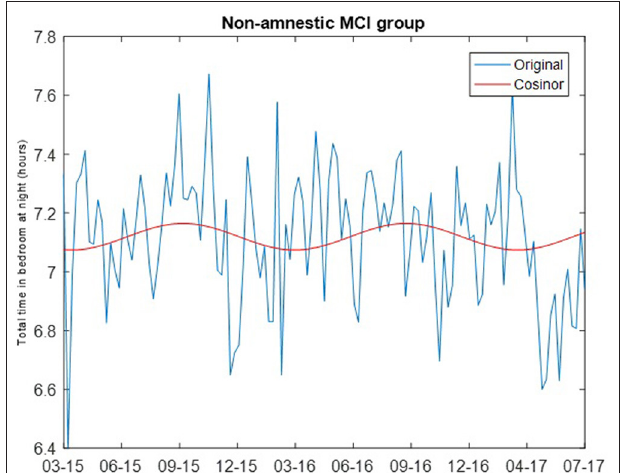
FIGURE 3 | Total time in bedroom at night of cognitively intact group compared to length of night. The total time in bedroom at night in hours per night (blue) of the cognitively intact group per day of year is compared to the length of the night in hours (red) in Portland, Oregon over the length of the